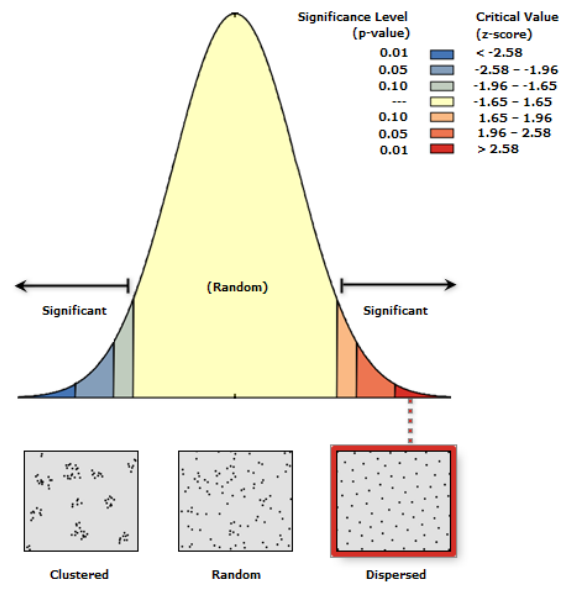
Figure 5. Distribution pattern of boreholes regarding Average Nearest Neighbor (ANN) report. The EMD as 100 m was considered to evaluate the horizontal and vertical distance spacing in Rockworks software and, therefore, develop the 3D geological model to have an efficient, accurate, but minimum computational effort discretization. According to the upper part of the workflow, a critical step was developing and homogenizing a catalog with 304 boreholes, containing their exact location, elevation above sea level, total depth, and the lithological unit at each depth. The description of the lithological units that were used and their codes are presented in Table 1. Nine lithological units were coded and visualized (Table 1). In addition, the Rockworks Borehole Manager tool was utilized to create the grid models for the subsur- face of each lithological unit in order to visualize them in 2D cross-sections and 3D dia- grams (lowest part of Figure 4). Table 1. Lithological units that correspond in the borehole database. Lithological Units